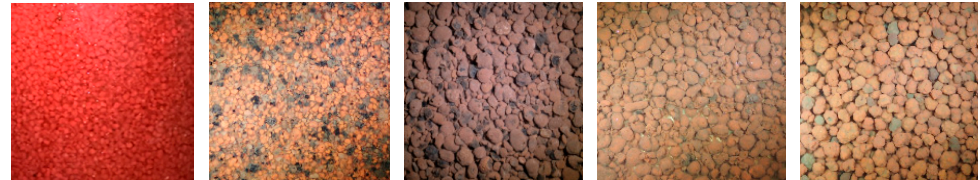
Figure 5. Examples of ANAMMOX granules: AMX only (left) and PN/AMX (4× right) with typical diameters of 1, 1–2, 2–5, 3–5, and 4–6 mm, respectively.